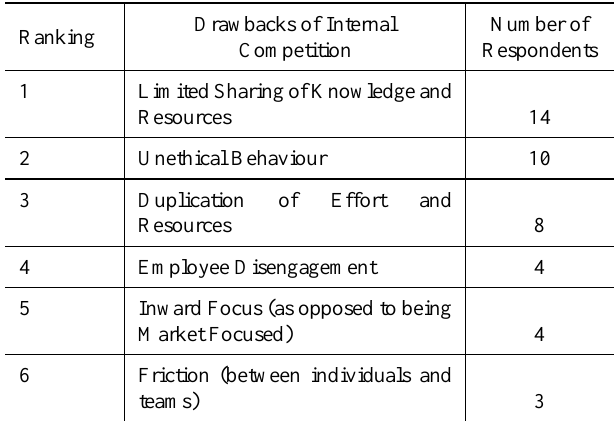
Table 3: Drawbacks of internal